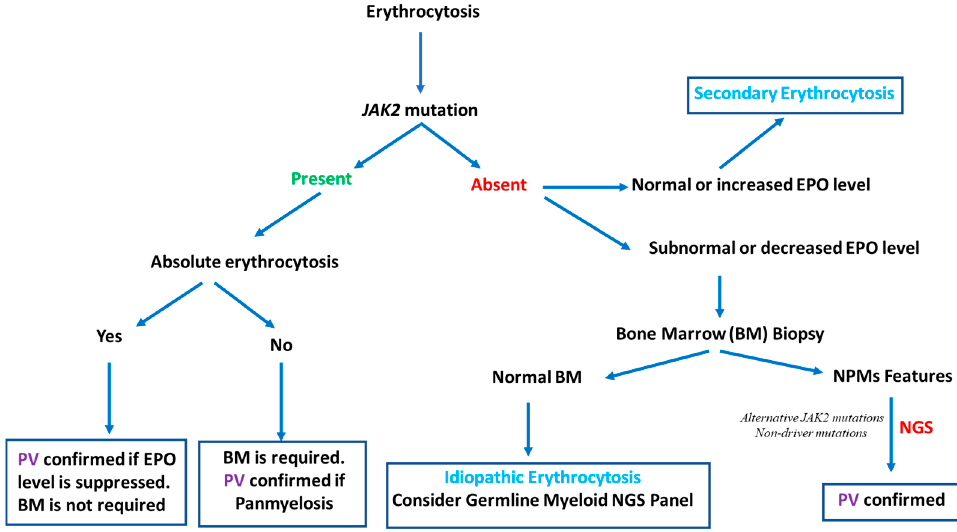
Figure 1. Erythrocytosis and PV diagnostic approaches: NGS contribution to PV diagnosis.